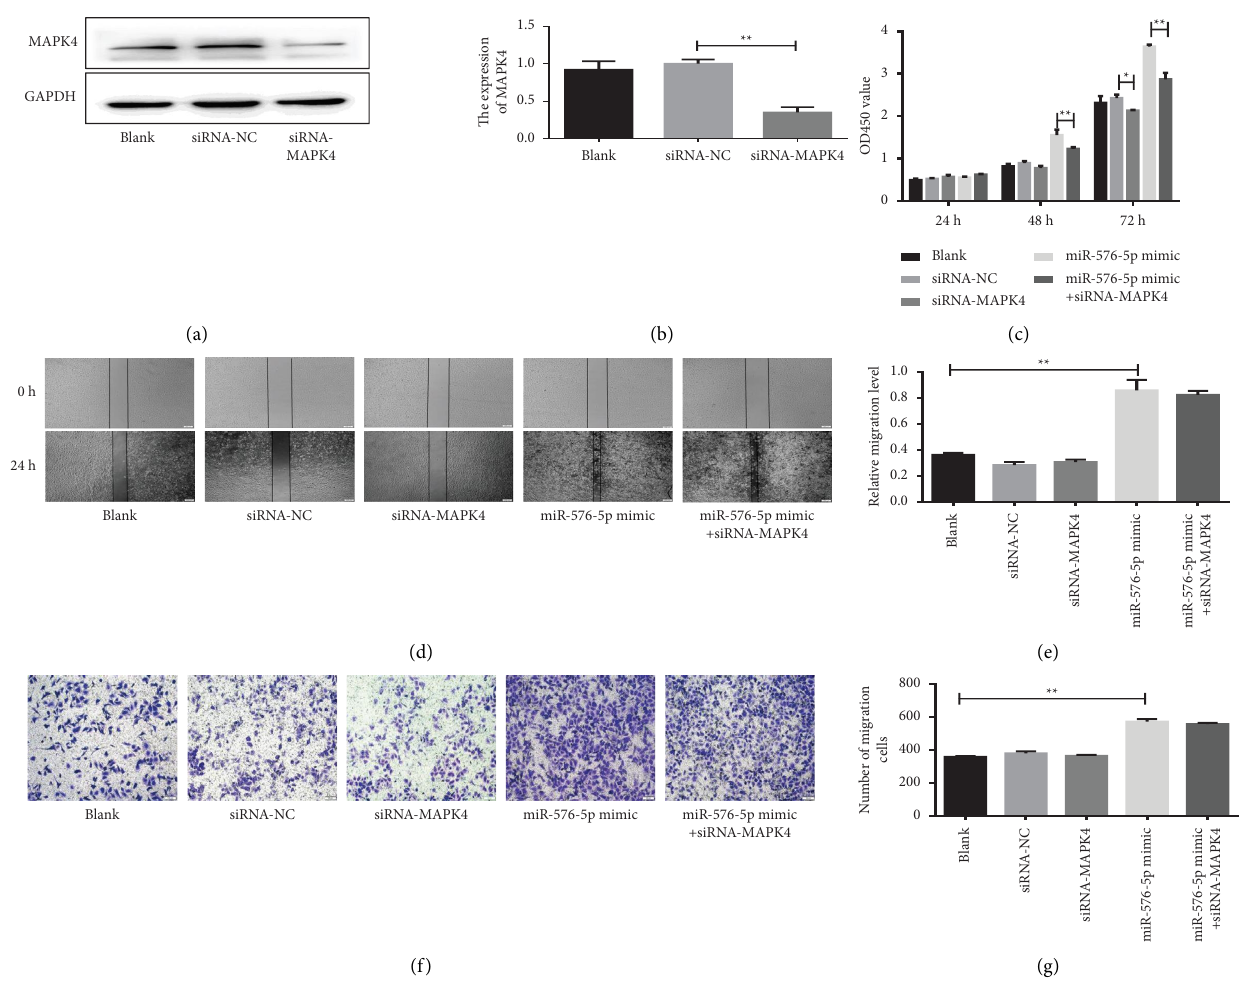
Figure 5: MAPK4 knockout inhibited the proliferation of TPC-1 cells. (a, b) MAPK4 expression in TPC-1 cells transfected with siRNA- MAPK4 and siRNA-NC. (c–g) Te efect of MAPK4 on the proliferation, migration, and invasion of TPC-1 cells was examined by CCK8, wound healing, and transwell assays. ∗ P < 0 . 05 ; ∗∗ P < 0 .